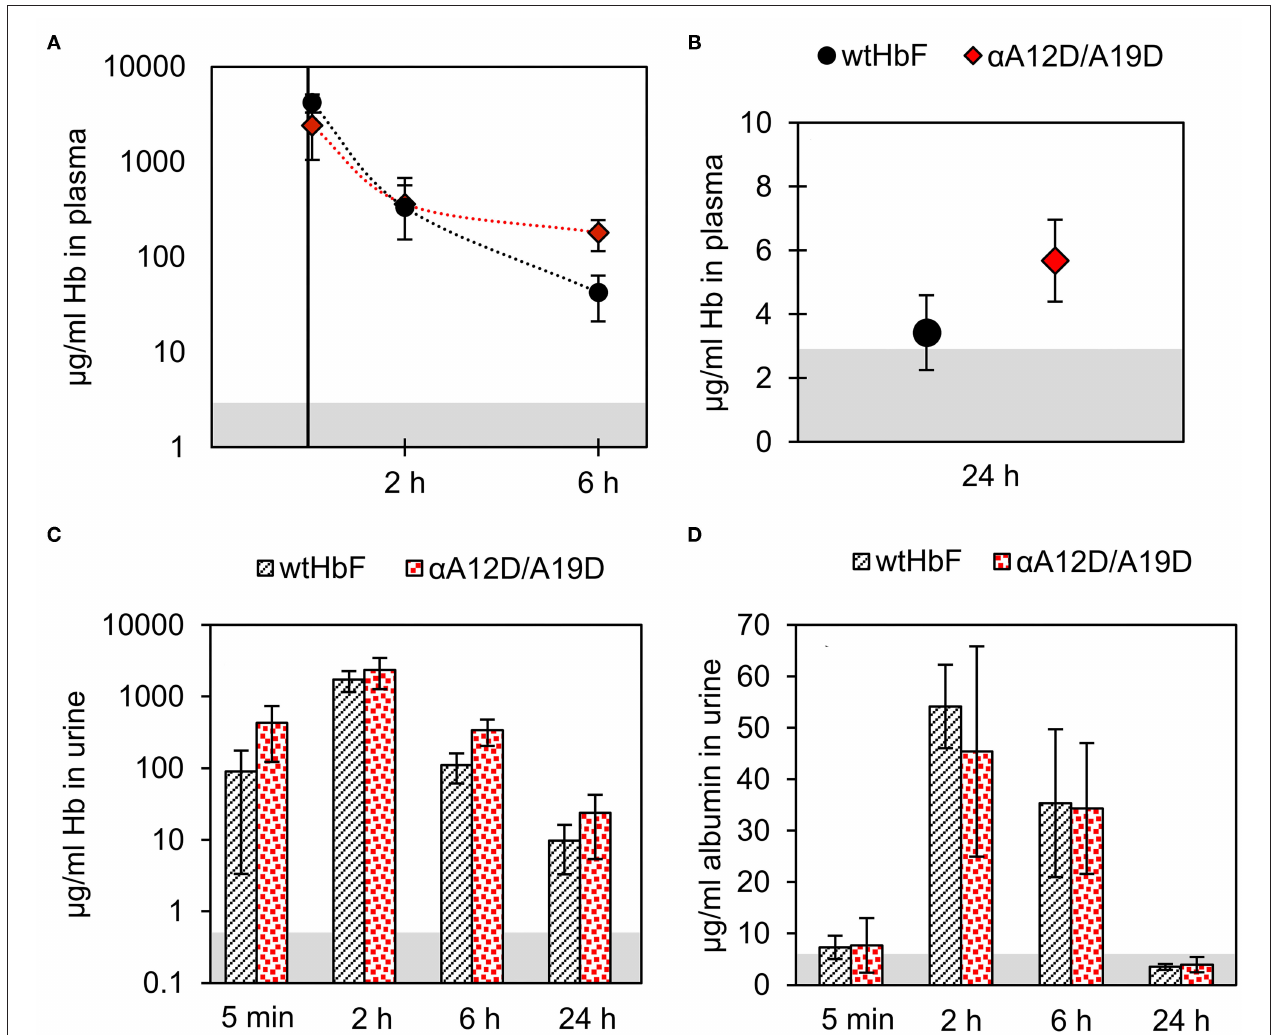
FIGURE 7 | The pharmacokinetics of wtHbF and the α A12D/A19D mutant were analyzed in plasma and urine samples at four different time-points (5min, 2, 6, and 24h, n = 5 per time point and Hb variant) by ELISA. Data is presented as mean ± SD. Differences are determined by independent t -tests with p < 0.05 significance level. The gray area in the graphs shows the signal of the non-injected control ( n = 5). Panels (A) and (B) show the results of the plasma analysis, and no difference is seen for the two first time points at 5min and 2h, but at 6 and 24h, significantly more α A12D/A19D mutant is detected compared to wtHbF. (C) In urine, the concentration of Hb was found to be similar between the mice injected with either wtHbF or α A12D/A19D, except for at 6h, where a significant difference is seen with α A12D/A19D having a higher concentration than wtHbF. (D) The albumin assay showed that the concentration of albumin in the urine with either protein variant was similar at each time